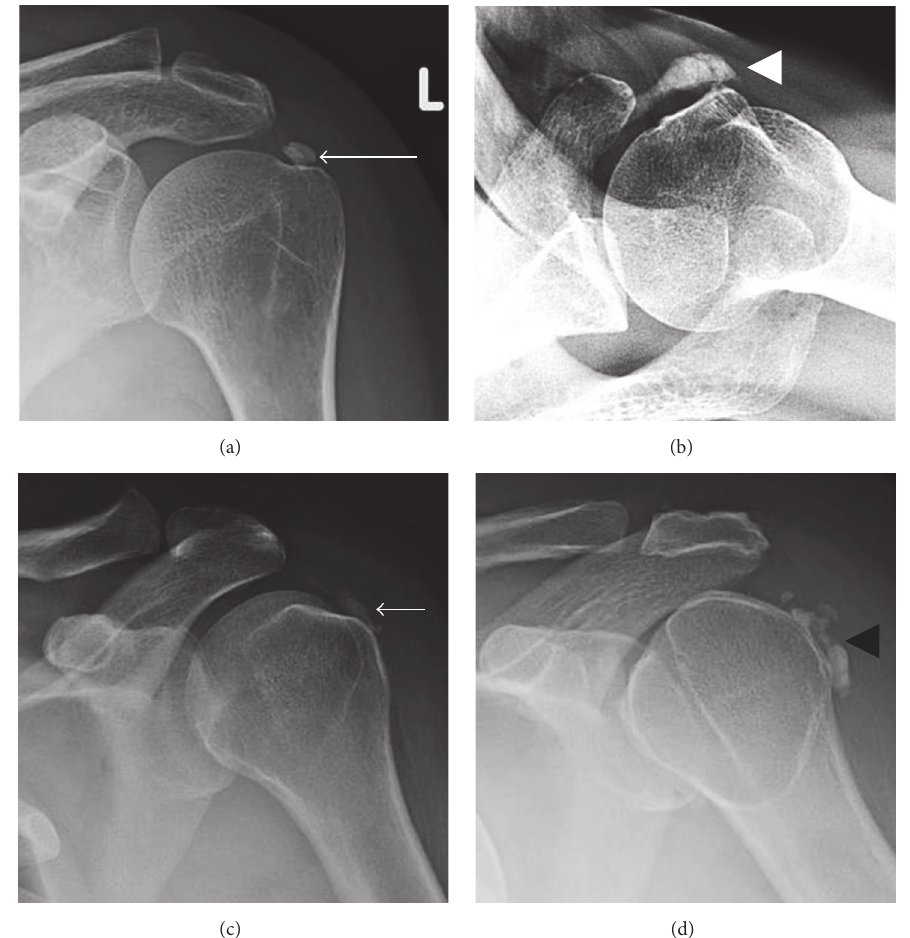
Figure 8: Calcific tendinopathy of the rotator cuff. (a) Calcific tendinopathy of the supraspinatus (long arrow) is best seen on AP shoulder radiograph in external rotation. (b) Calcific tendinopathy of the subscapularis (white arrowhead) is best appreciated on axillary view of the shoulder. (c) and (d) AP views of the shoulder in internal rotation are best for appreciating calcific tendinopathy of the infraspinatus (short arrow) and teres minor (black arrowhead).